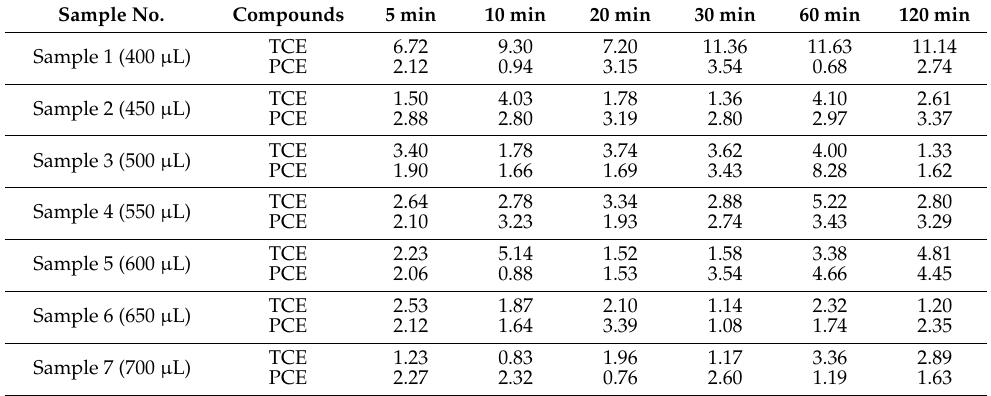
Table 6. Relative standard deviation (R.S.D.; %) of samples adsorbed by silica gel (n = 4). Sample